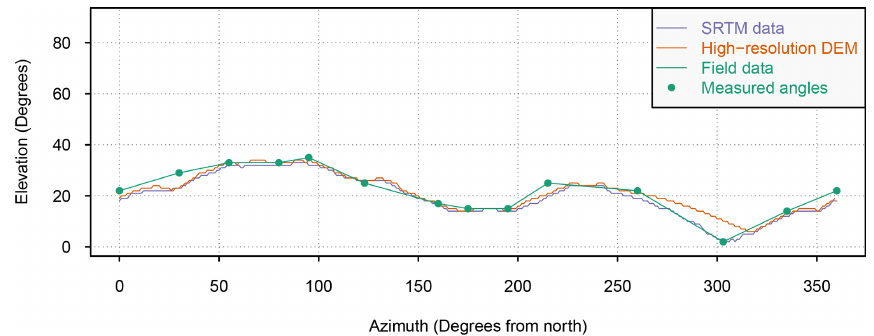
Figure 11. Horizon around the sampling surface on the SW-2 boulder according to SRTM data, the 1m DEM and field data. Elevation and azimuth angles were computed with the skyline and skytable functions in ArcMap